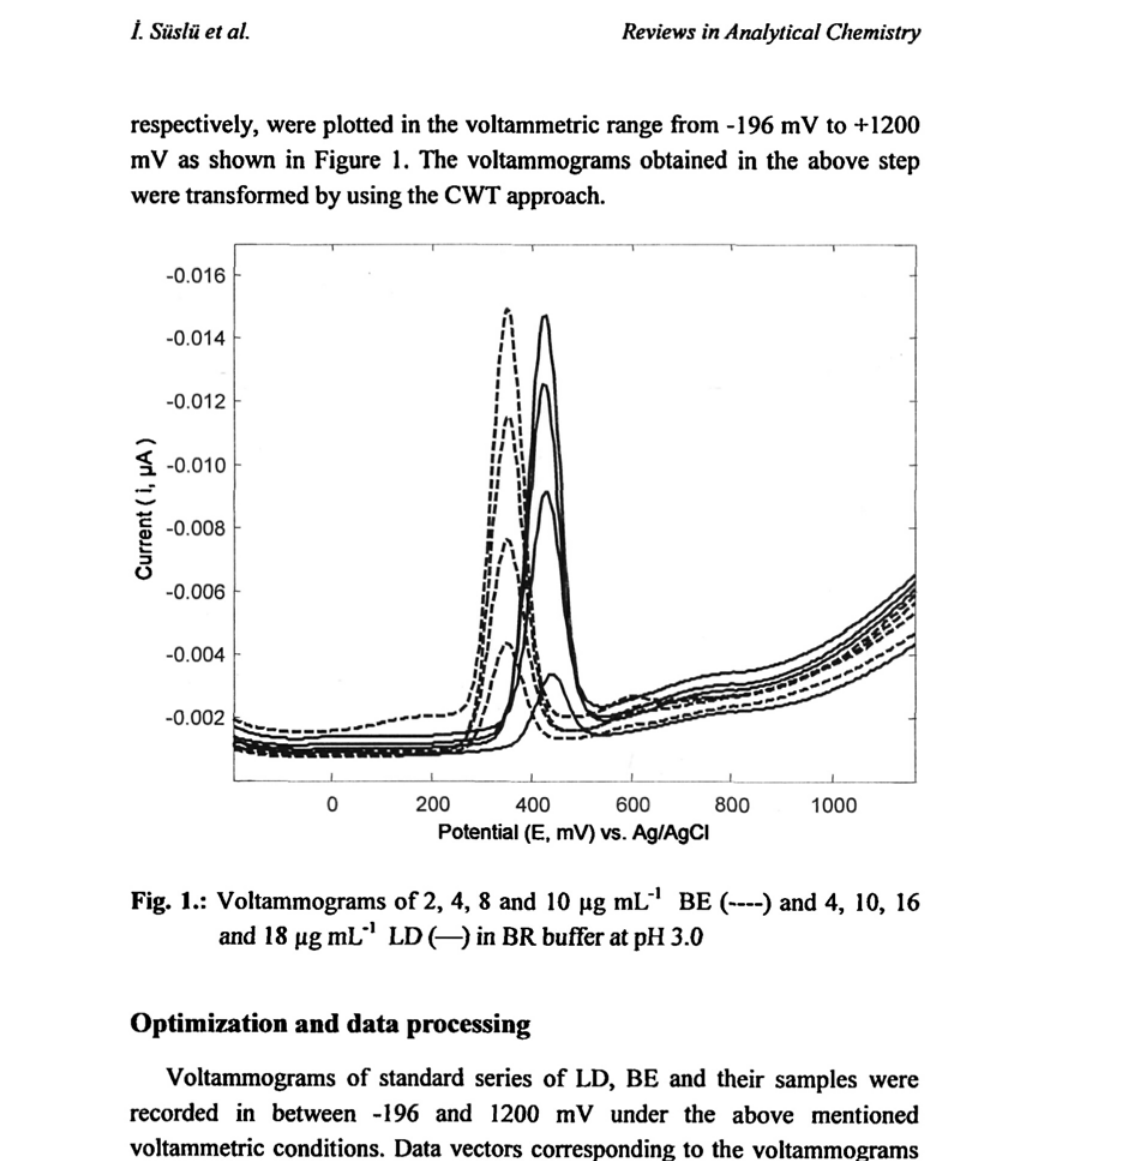
Fig. 1.: Voltammograms of 2, 4, 8 and 10 μg mL' 1 BE (—) and 4, 10, 16 and 18 μg ml/ 1 LD (—) in BR buffer at pH